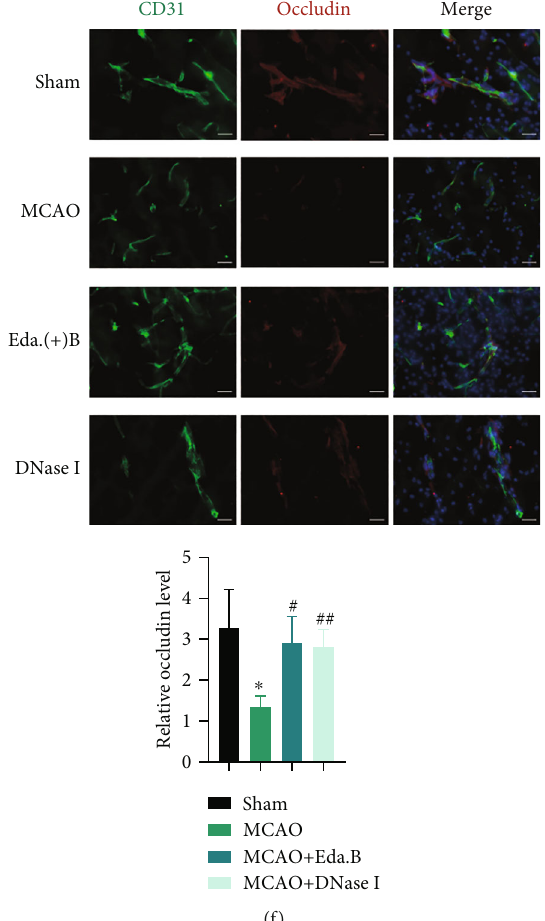
Figure 5: Eda.B and DNase I administration alleviated degradation of TJ-associated protein in MCAO mouse cortex. (a, b) mRNA expression of occludin and claudin5 in mouse cortex at day 1 and day 3 after stroke. (c, d) Protein levels of occludin and claudin5 at day 1 and day 3 after stroke. Representative bands are on the left. (e, f) Representative images of sections stained with claudin5 or occludin (red), CD-31 (green), and DAPI (blue). Scale bar = 20 μ m. Mean fl uorescence intensity is on the bottom. ∗ P < 0 : 05 (MCAO group vs. Sham group), ∗∗ P < 0 : 01 (MCAO group vs. Sham group), # P < 0 : 05 (Eda.B group or DNase I group vs. MCAO group), and ## P < 0 : 01 (Eda.B group or DNase I group vs. MCAO group), n = 5 in each